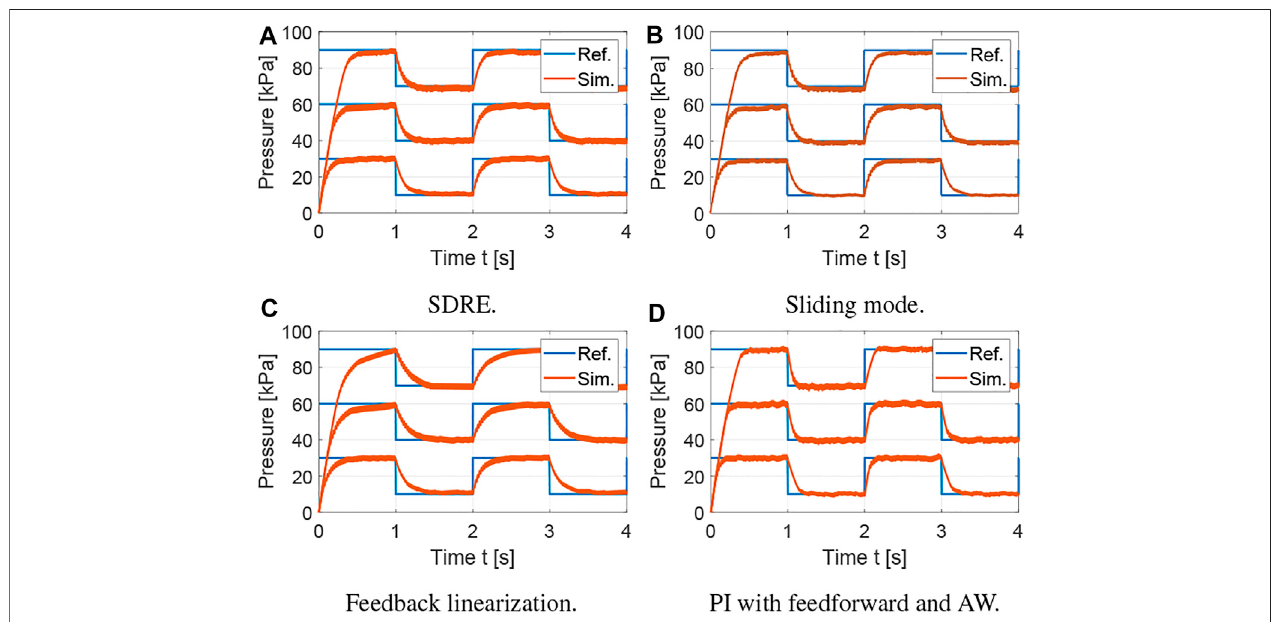
FIGURE 4 | Evaluation of robustness of control strategies to variation in pressure references with varying offsets. (A) SDRE. (B) Sliding mode. (C) Feedback linearization. (D) PI with feedforward and AW.